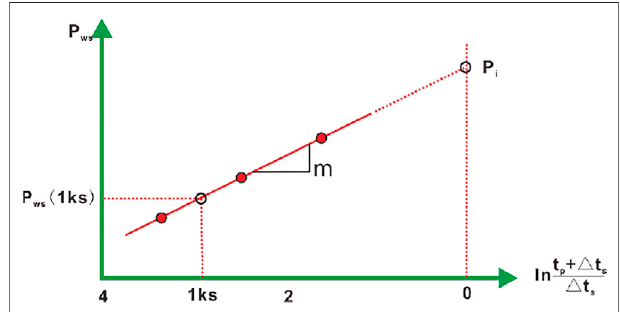
FIGURE 2 | The plot of Horner (Li,